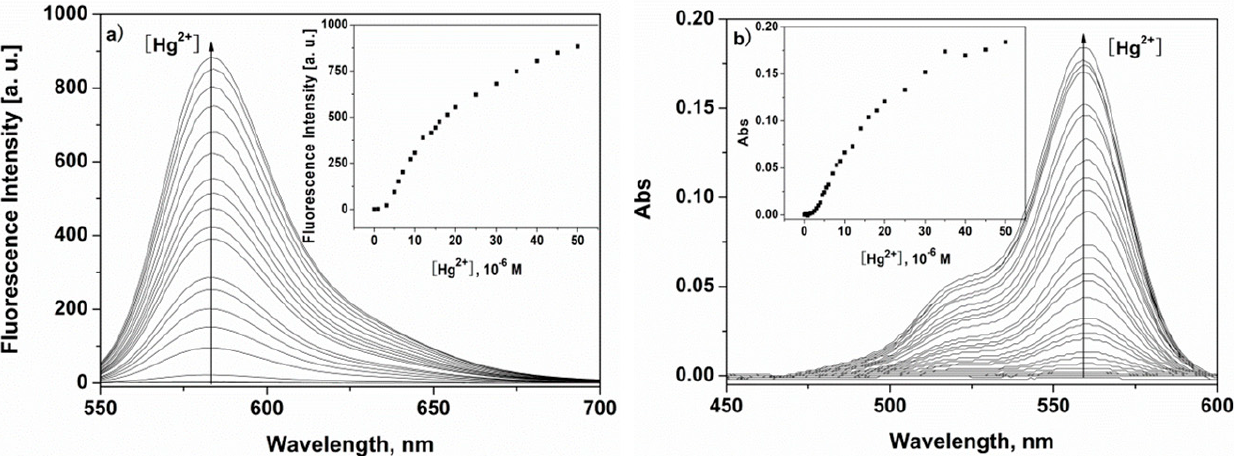
Figure 3. Fluorescent titration ( a ) and absorption titration ( b ) experiments of P (5 µ M) with different concentrations of Hg 2+